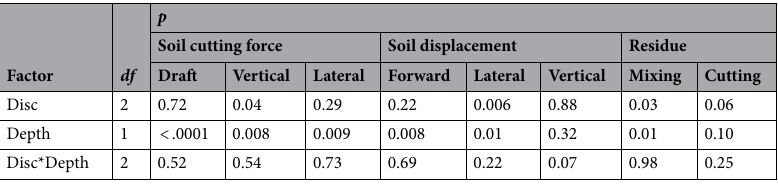
Table 1. Summary of ANOVA test